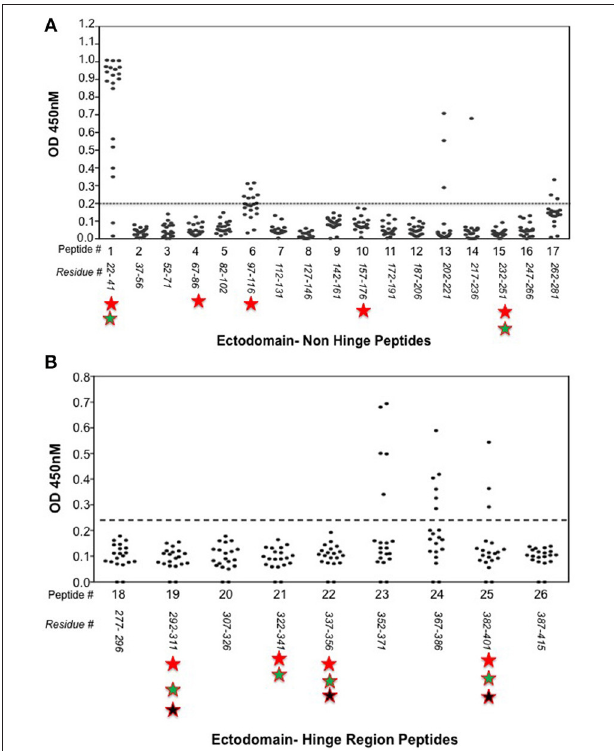
FIGURE 5 | Detecting linear antibodies by indirect peptide ELISA. (A) Antibodies to non-hinge region peptides: 17 overlapping 20-mer peptides representing the non-hinge region of the TSHR ectodomain spanning residues 1–281 of the ectodomain was used in the indirect peptide ELISA to detect linear binding antibodies in the serum of immunized mice. The cut-off as indicated by the dotted line is the highest value of all peptides reacted with control animal serum plus 2 standard deviation above the mean. Peptide 1 (residues 22–41) of the receptor showed overwhelming predominance of antibody response (85%) compared to other peptides 6 and 13. Antigenicity predicted by more than two open source software is marked below each peptide by stars. (B) Antibodies to hinge region peptides: To examine hinge specific antibodies in the immunized animals we used 9 peptides covering the entire hinge region (residues 277–415). The majority of immunized animals showed linear binding antibodies to peptides 23, 24, and 25 that were above cut-off (dotted line) determined by the control serum samples plus 2 standard deviation. Overall, 40% of the immunized mice showed antibody response to these novel hinge regions “hot-spots.” Antigenicity predicted by more than two open source software is marked below each peptide by stars.